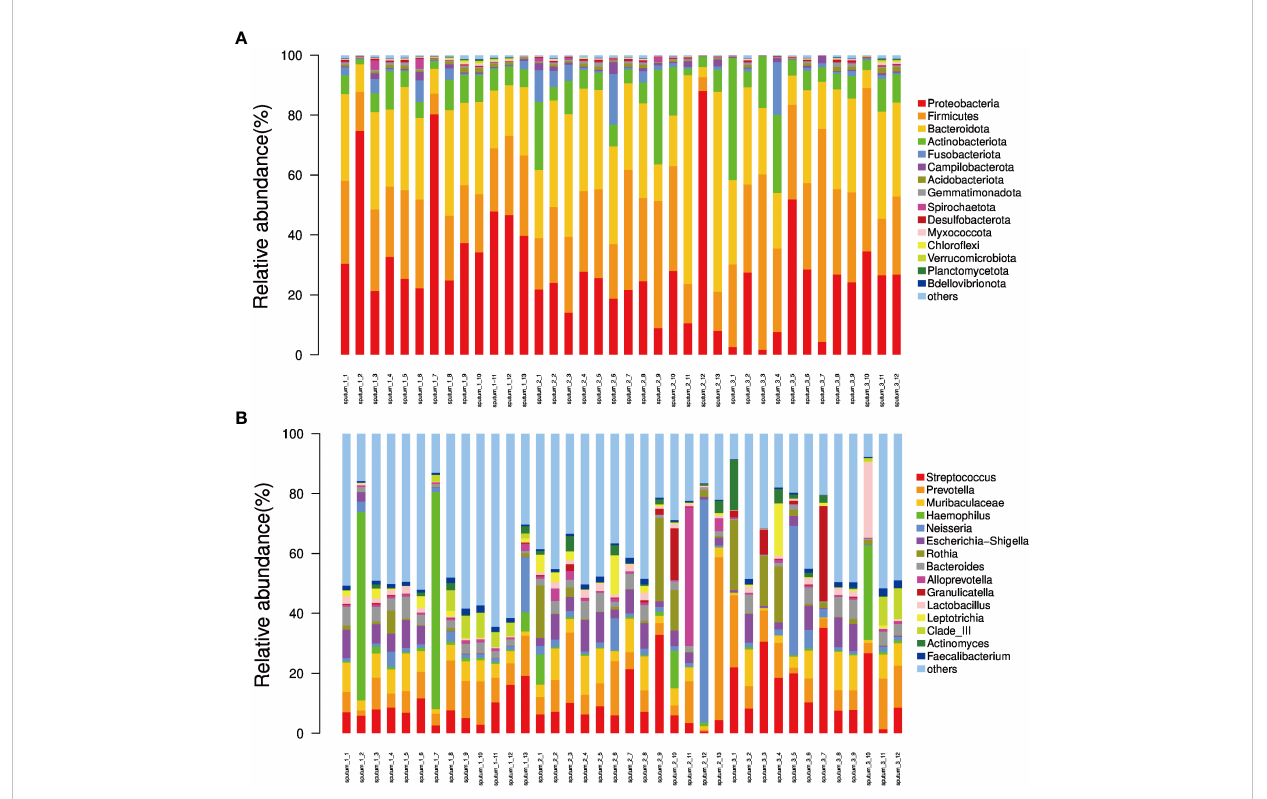
FIGURE 4 The relative abundance of phyla and genera derived from sequencing of each sputum sample. (A) Bar plot of relative abundance in each sample at the phylum level; (B) Bar plot of relative abundance in each sample at the genus level.